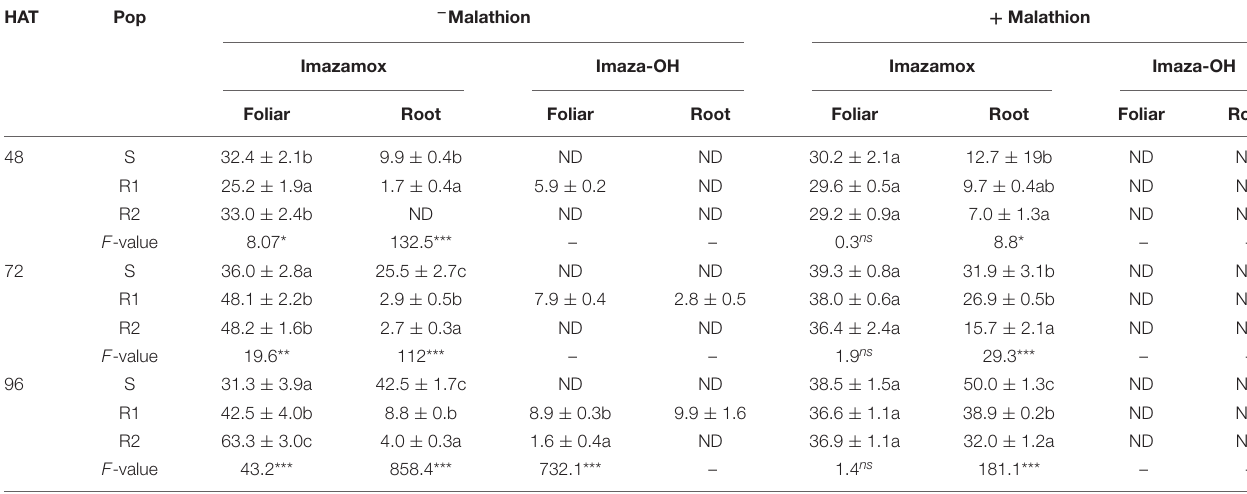
TABLE 6 | Imazamox concentration and its hydroxyl metabolite (Imaza-OH) in foliar and root extracts from R (R1 and R2) and S populations of G. coronaria at 48, 72, and 96 HAT ( µ g/g − 1 ). HAT